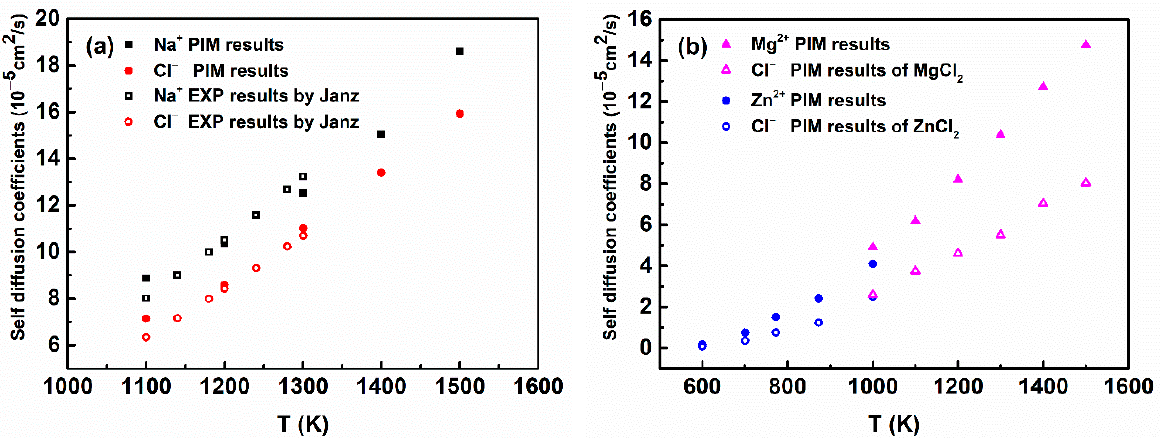
Figure 11. PIM simulated results of self-diffusion coefficients in different temperature: ( a ) Na ion and Cl; ( b ) MgCl 2 and ZnCl 2 .